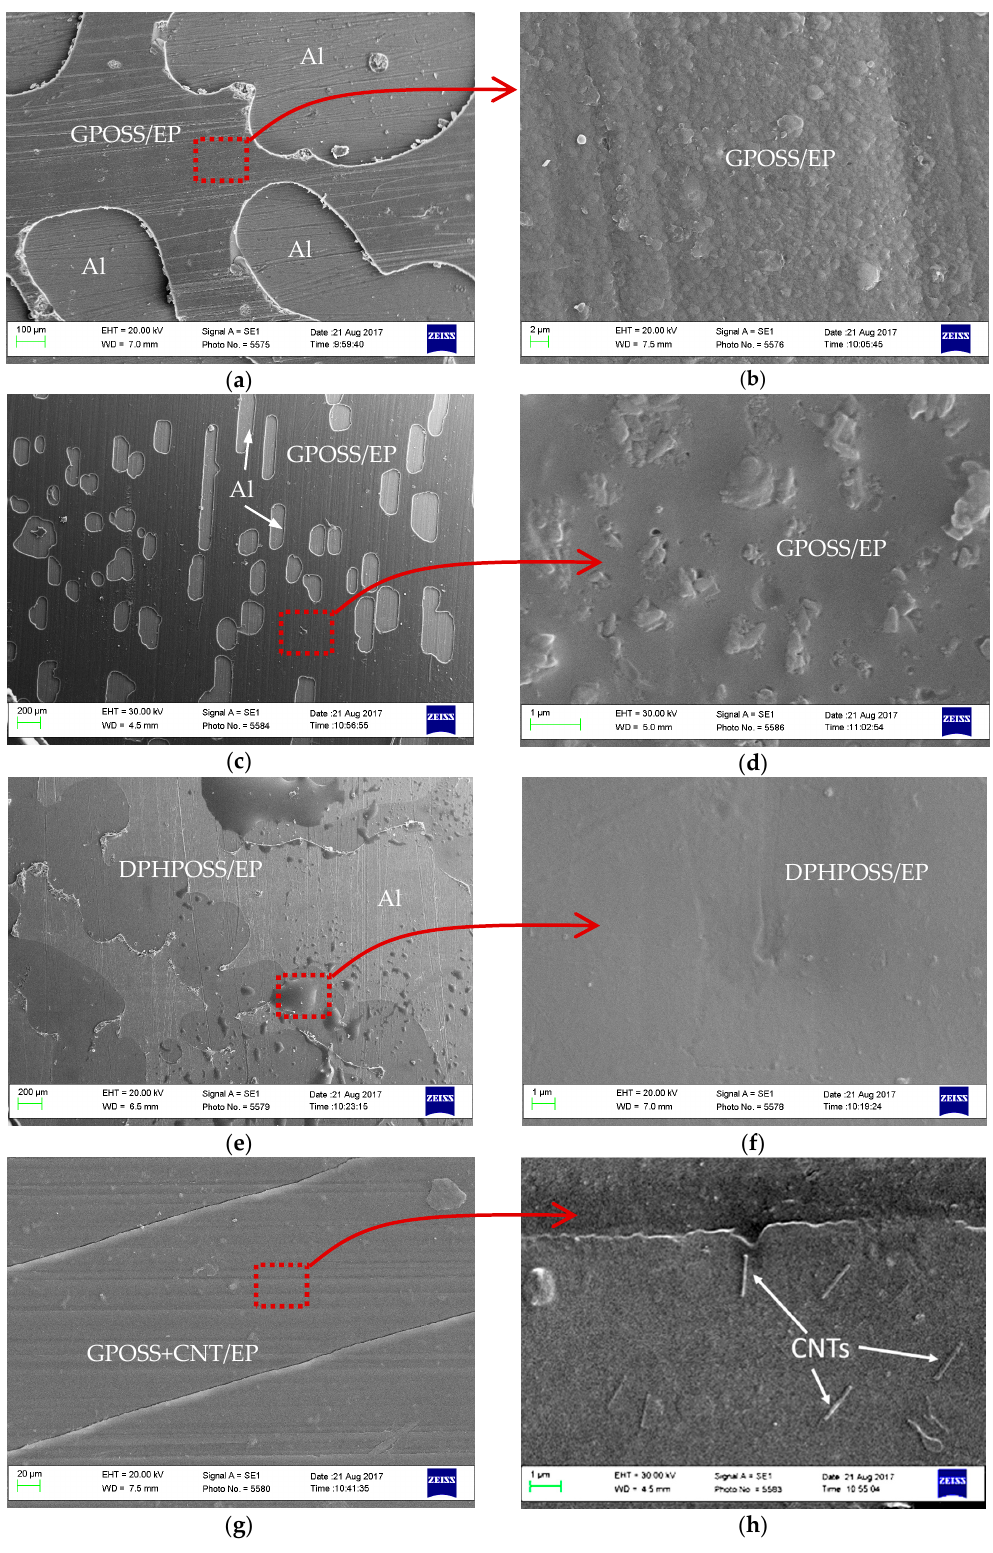
Figure 10. Fractographic analysis of fracture surfaces in the single lap joints (SLJs) with various epoxy nanocomposites: ( a ) Treated Al with 5 wt % GPOSS; ( b ) Treated Al + 5 wt % GPOSS; ( c ) Untreated Al + 5 wt % GPOSS; ( d ) Untreated Al + 5 wt % GPOSS; ( e ) Treated Al—5 wt % DPHPOSS; ( f ) Treated Al—5 wt % DPHPOSS; ( g ) Treated Al—5 wt % GPOSS + 0.5 wt % CNT; ( h ) Treated Al- 5 wt % GPOSS + 0.5 wt %